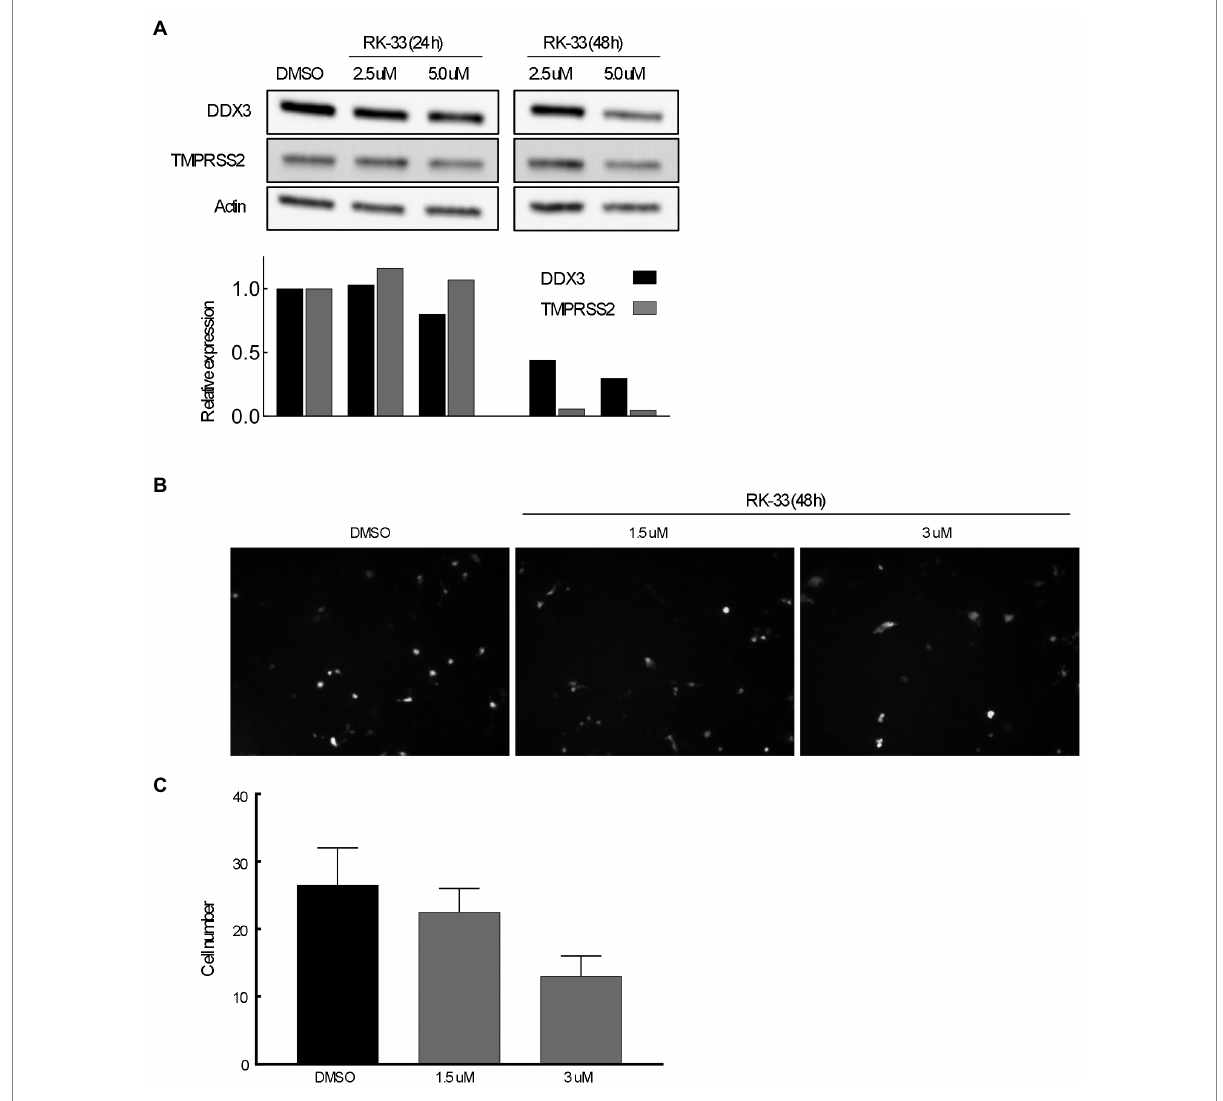
FIGURE 6 (A) Immunoblot of proteins extracted from Calu-3 cells treated with increasing concentrations of RK-33 for 24 and 48 h. Densitometry graph included. (B) Effect of increasing concentrations of RK-33 on Calu-3 cells for 48 h that were infected with pseudotyped virus. (C) Quantification of Calu-3 cells seen in (B)